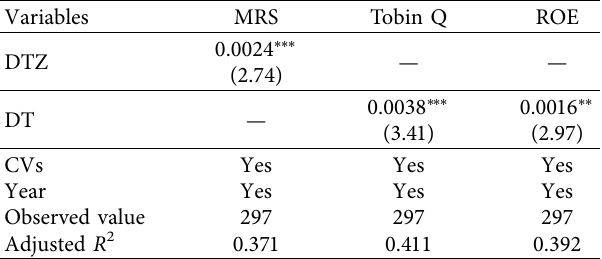
Table 7: Mediating effect of internal